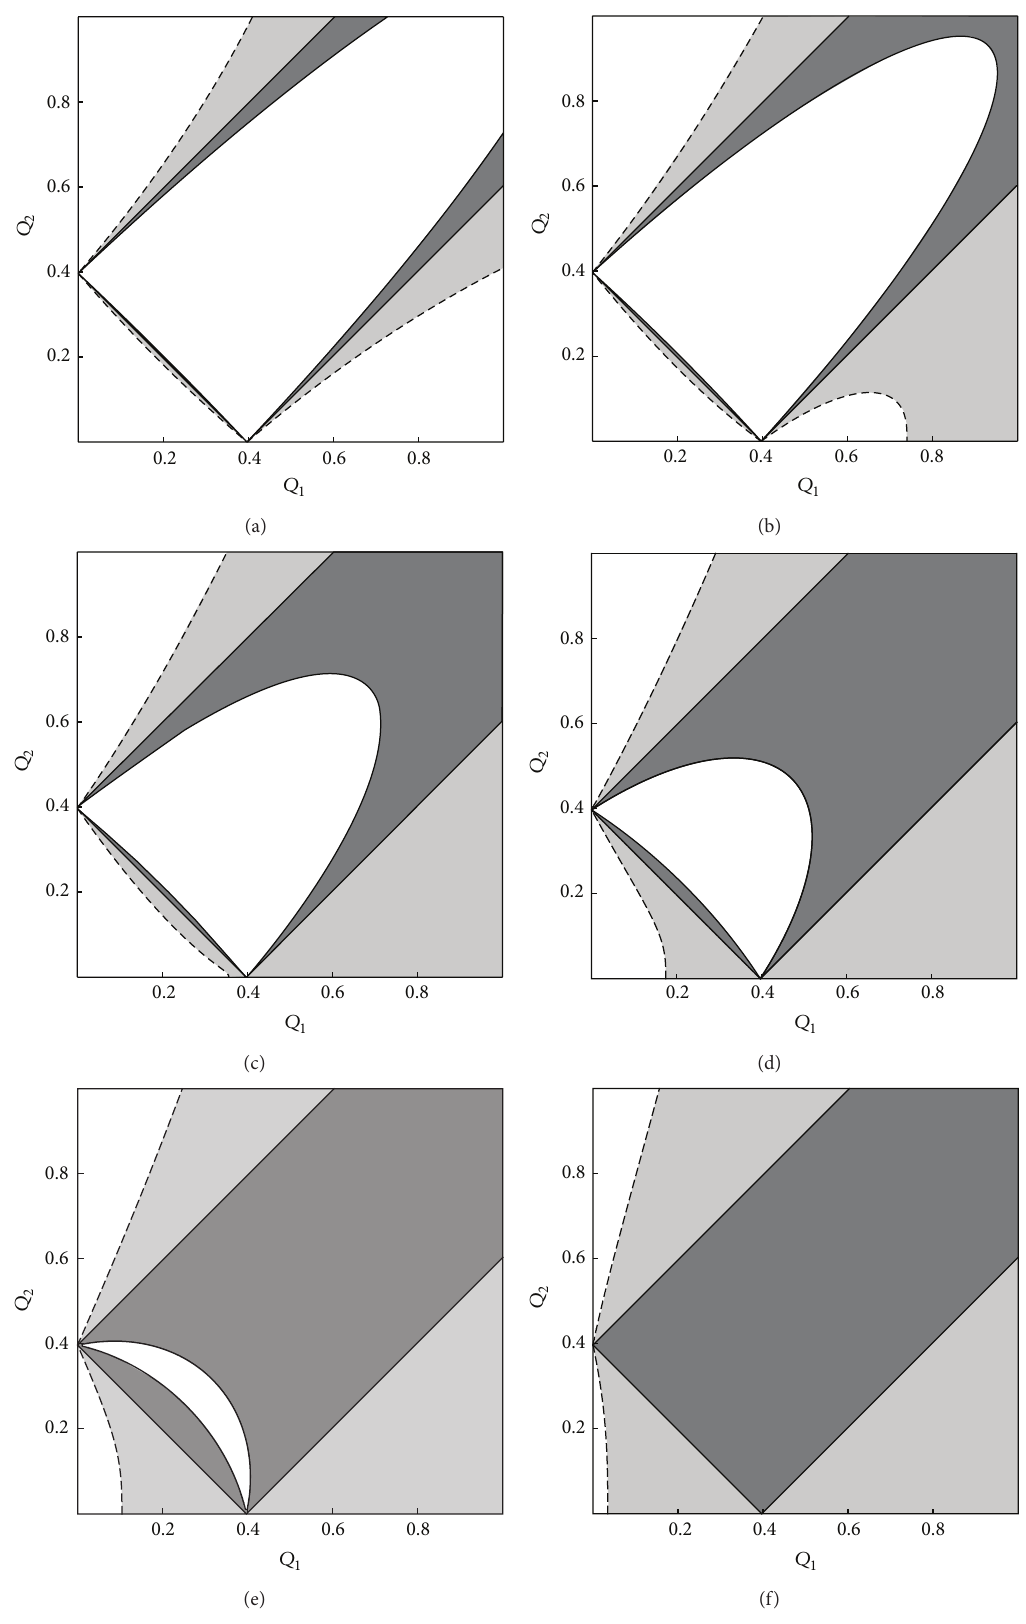
Figure 2: Stability regions of all equilibrium points in the (𝑄 1 , 𝑄 2 ) plane for 𝜔 = 0 . 25 and 𝜇 = 0 . 5, 𝜇 = 0 . 2, 𝜇 = 0 . 1, (from (a) to (c)) 𝜇 = 0 . 05, 𝜇 = 0 . 03, and 𝜇 = 0 . 01 (from (d) to